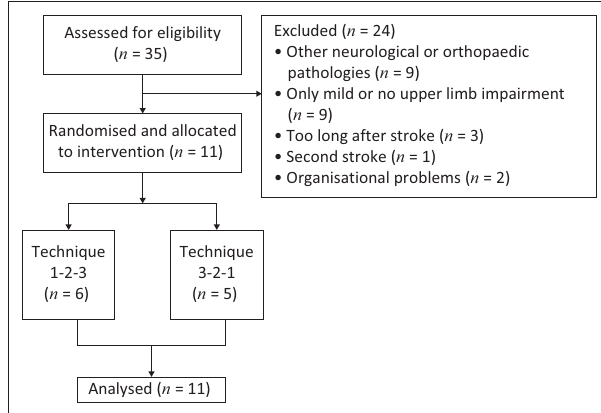
FIGURE 1: Flowchart of study